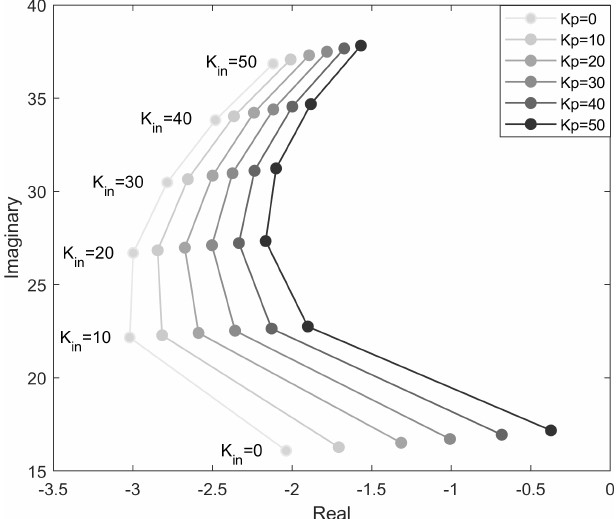
Figure 18. Sensitivity analysis of converter control-based modes to K p and K in .